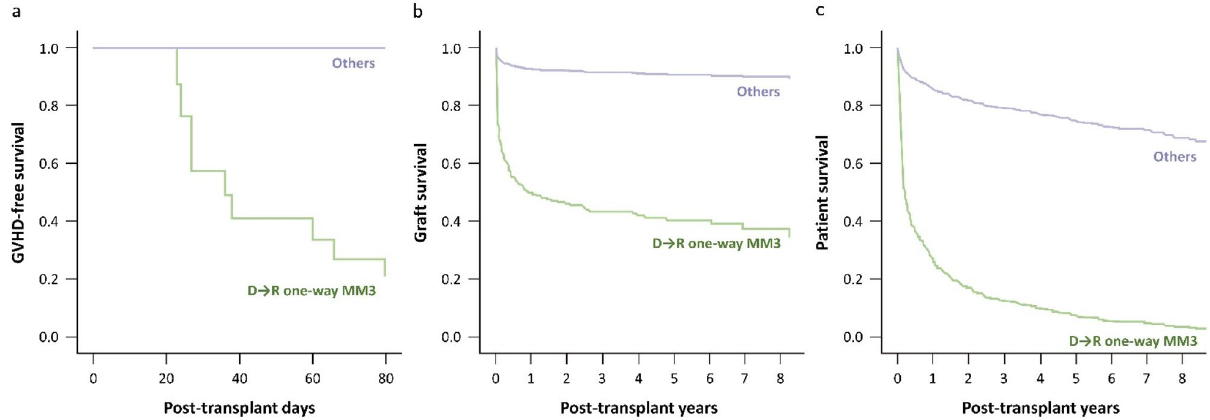
Figure 2. GVHD-free, graft and patient survival of patients with “donor against recipient one-way mismatch at three loci”.